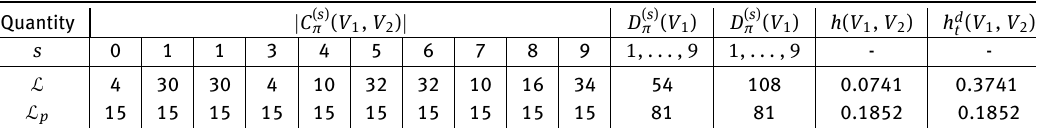
Table 2: Results of spectral bisection using the second eigenvectors of L and L p to minimise h and h d 10 , respectively, for the Ellingham-Horton 54 graph. The partitions V 1 , V 2 are obtained using the method described in Sections 2 and